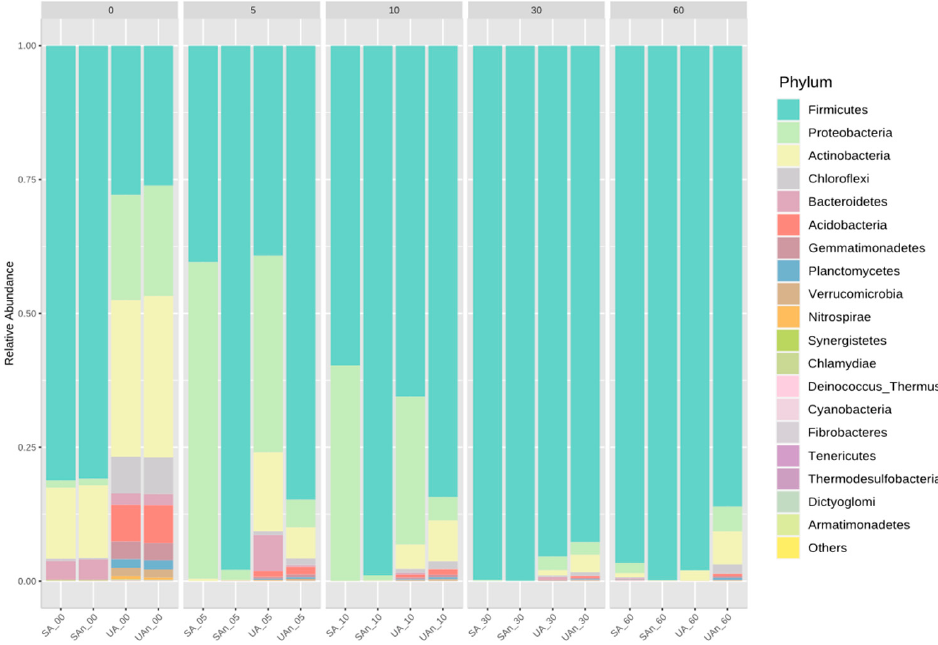
Figure 7. Relative abundance of the top 20 ASVs at genus level during decomposition of poultry carcass. “Others” represent taxa with counts < 10. UA, unsterilized soil–aerobic condition; SA, sterilized soil–aerobic condition; UAn, unsterilized soil–anaerobic condition and SAn, sterilized soil–anaerobic condition. The 0, 5, 10, 30, and 60 represent the sampling period.